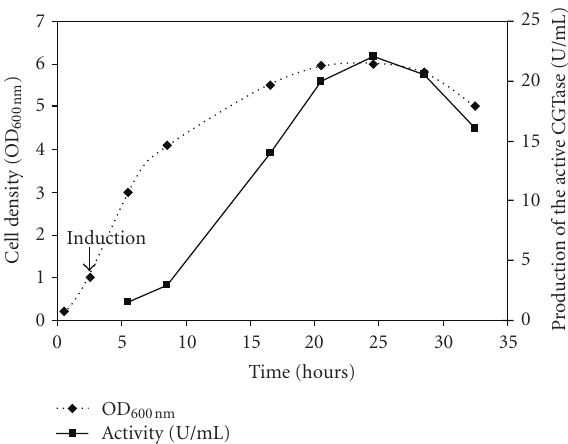
Figure 5: Evolution of bacterial cell growth and the active US132 CGTase production generated by E. coli ER2566/pSJ8 cultivated in 2TY medium. Induction was performed by 16mg/L IPTG when culture reached OD 600nm between 0.8 and 1. Following the IPTG induction, the culture temperature is shifted from 37 to 19 ◦ C.